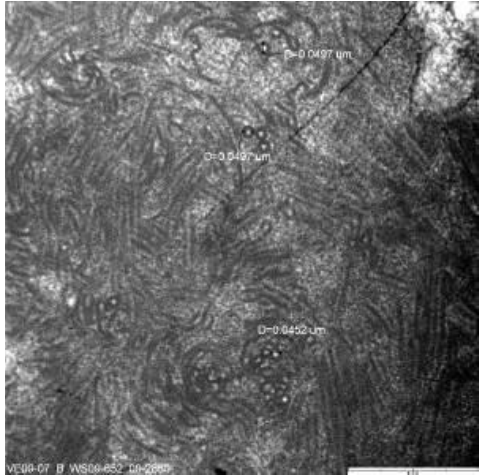
FIGURE 8. EM: measurements of